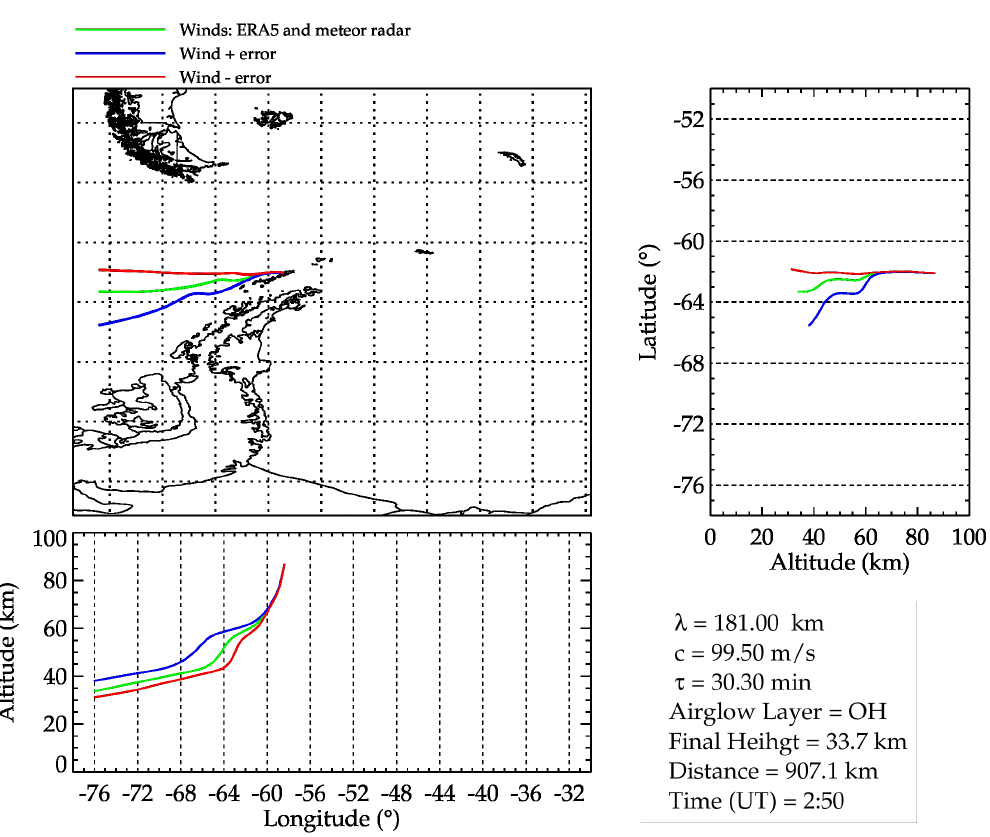
Figure 13. Ray paths of the wave # 8. The first panel shows the horizontal ray traced path of the wave in a rectangular map around EACF. The bottom panel shows the path concerning the altitude and the longitude. The right panel shows the path concerning the latitude and altitude. Green lines indicate ray paths calculated with the ERA5 and radar interpolated data set, while the blue and red lines indicate the ray paths calculated with a deviated wind data